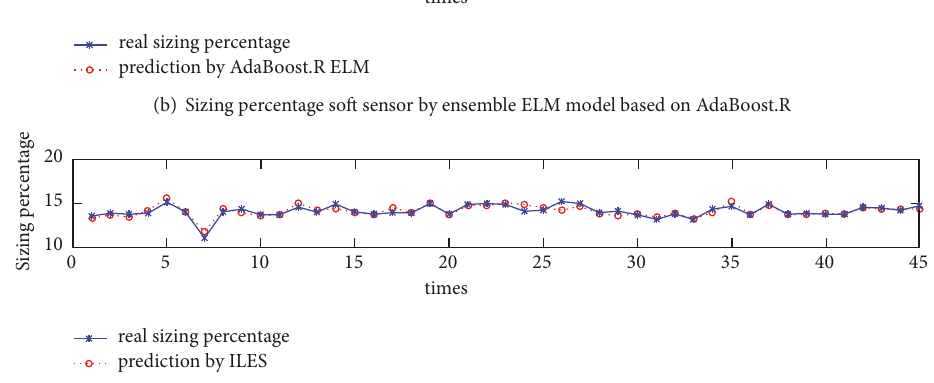
(c) Sizing percentage soft sensor by ILES model Figure 4: The result of the sizing percentage soft